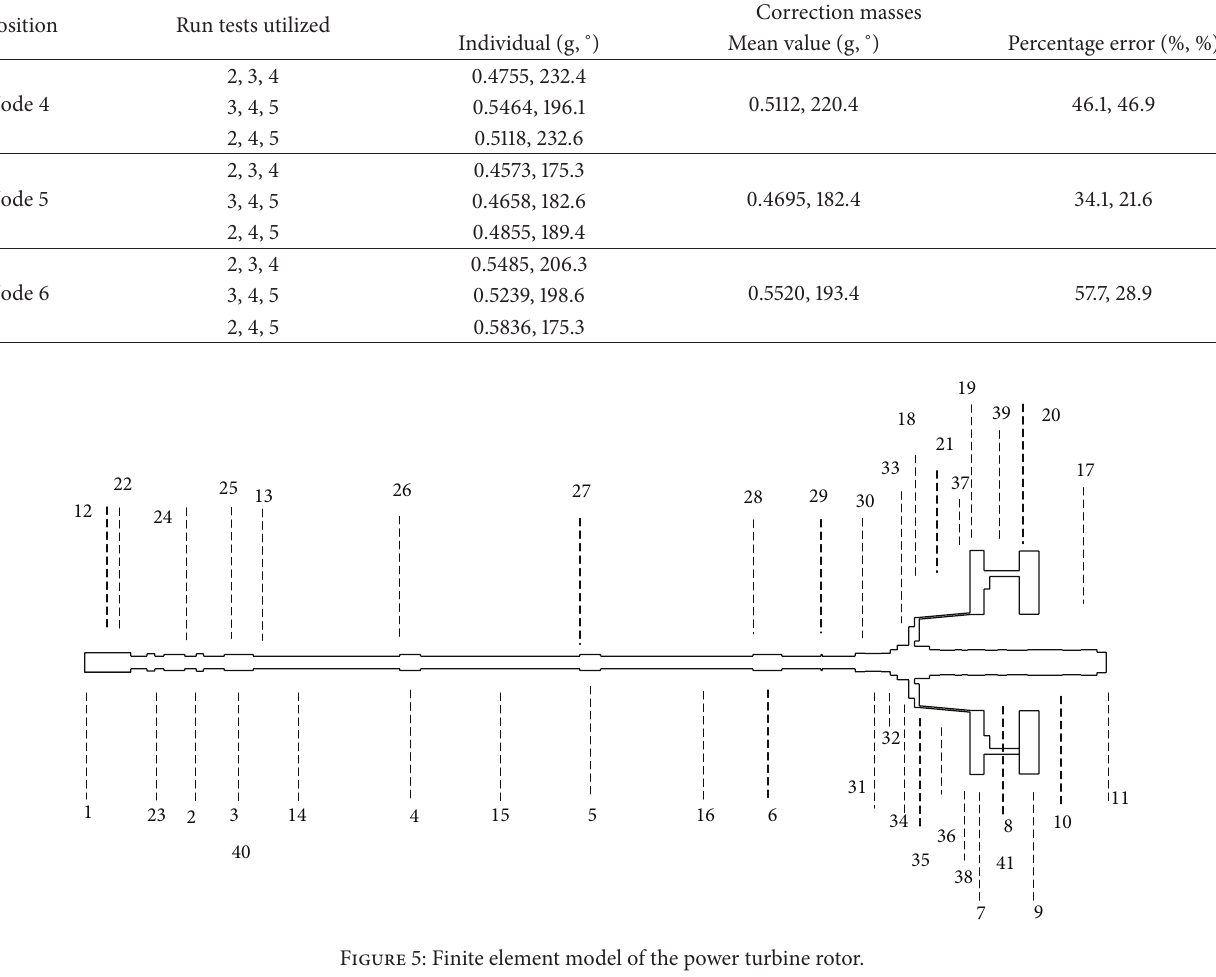
Table 6: Correction masses recognition for turbine rotor at 7800 r.p.m.